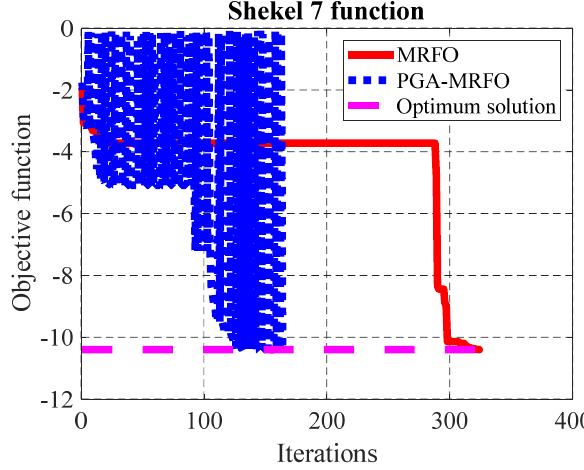
Figure 10. Converges curves for F 22 .